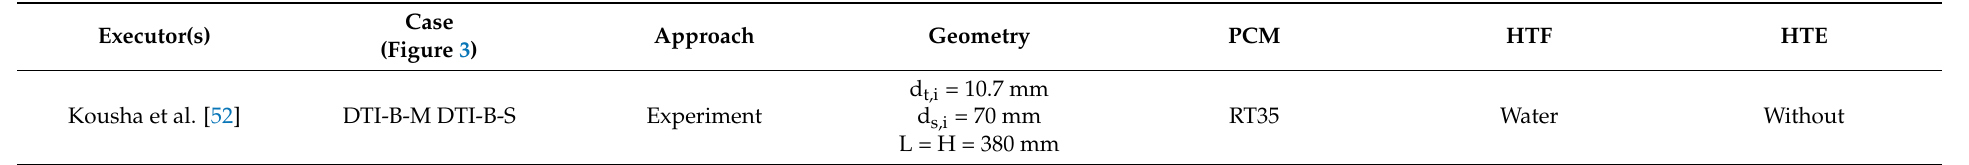
Table 3. Studies dealing with inclined double-tube